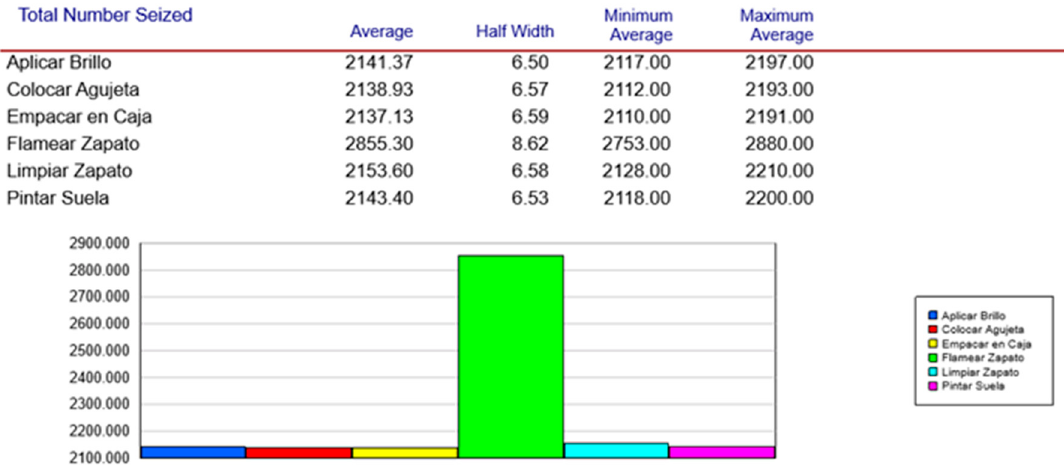
Figure A6. Final production of each activity during the process with a 7.5 h shift, Proposal.